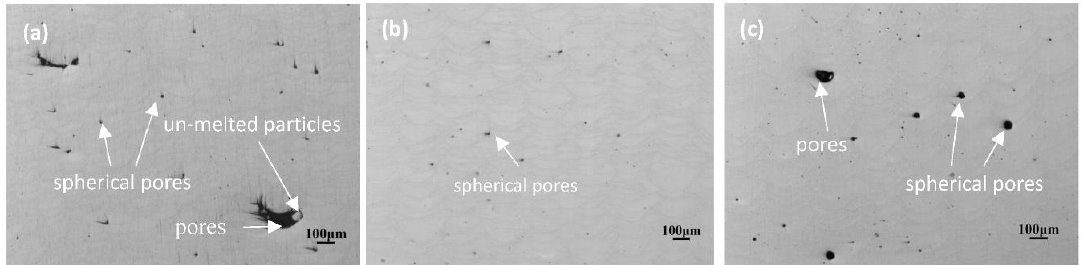
Figure 10. OM images of the cross-section microstructures of AlSi10Mg parts fabricated at different ET: ( a ) 100 μs; ( b ) 140 μs and ( c ) 180 μs. The PD is fixed at 80 μm.